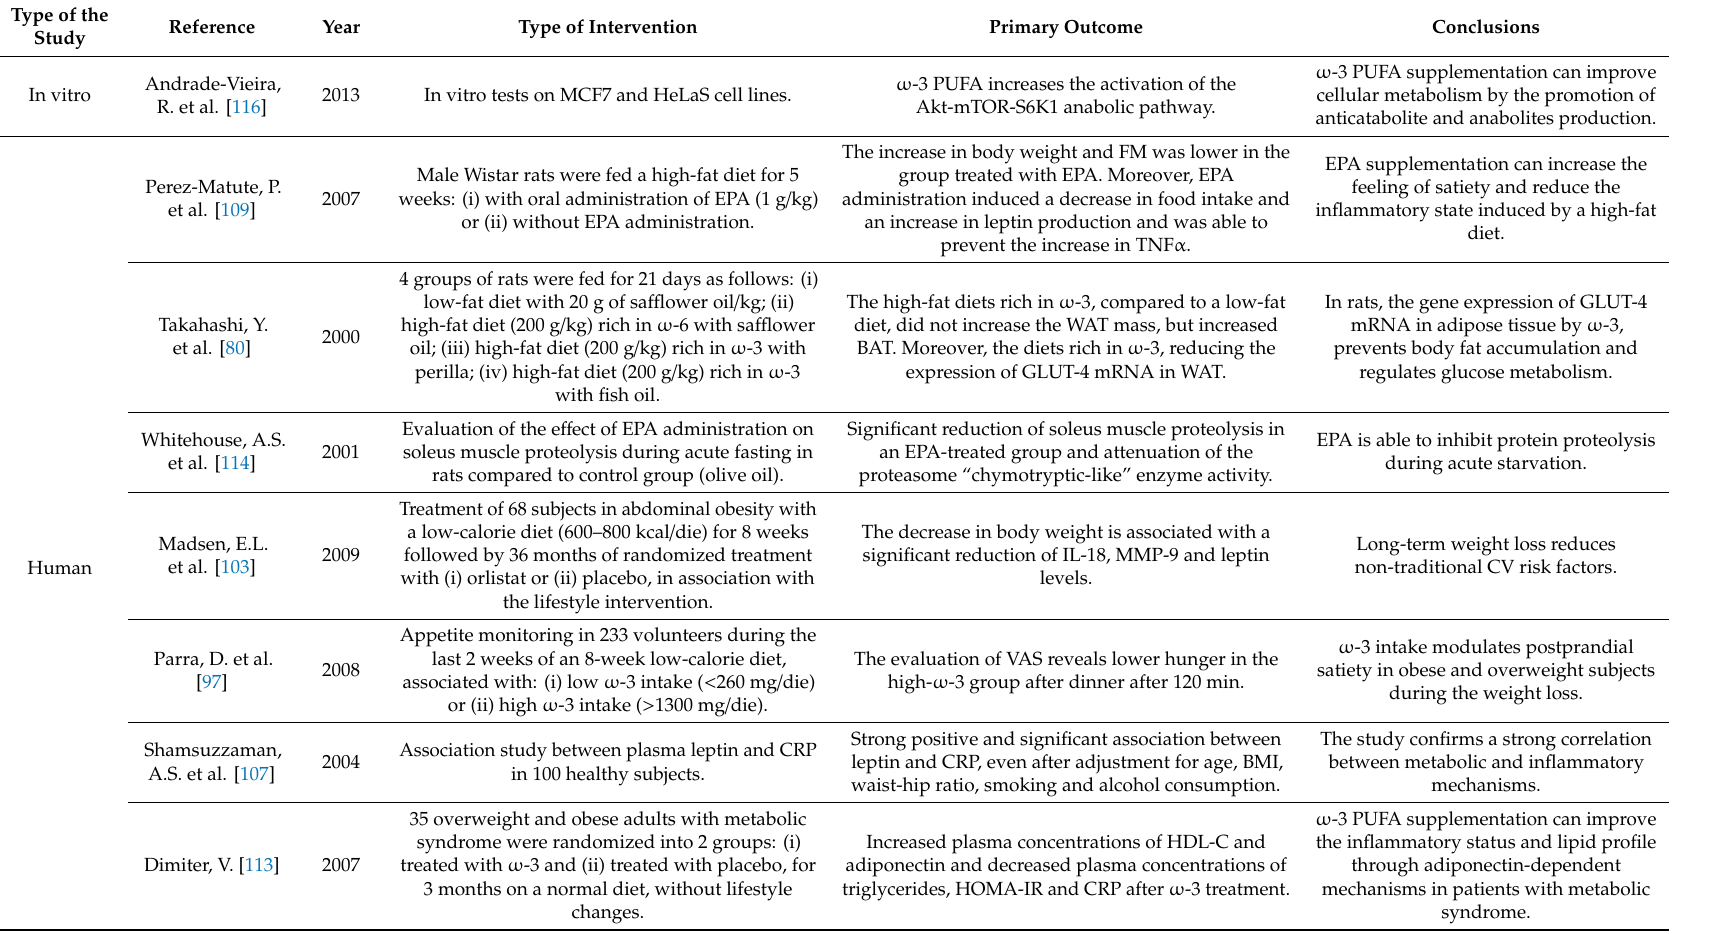
Table 5. Studies on PUFAs and metabolic